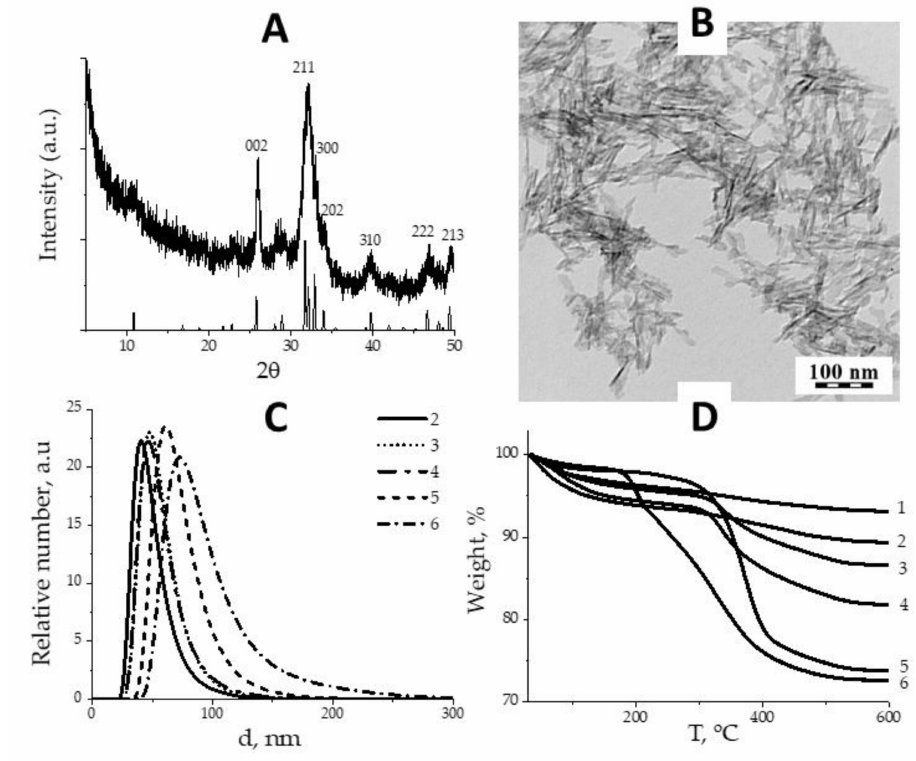
Figure 1. XRD pattern of hydroxyapatite (HAP) nanoparticles (NPs) ( A ); TEM micrograph of HAP NPs ( B ); number weighted particles size distributions ( C ) and thermograms ( D ) of HAP NPs coated with: (1) naked, (2) PHPMA5000, (3) POX5000, (4) POX10000, (5) PEG5000, (6)